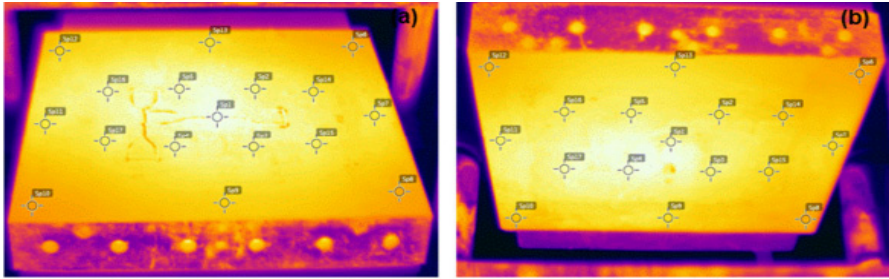
Figure 1. Thermal map of the plateaus of the press. ( a ) Lower and ( b ) upper.